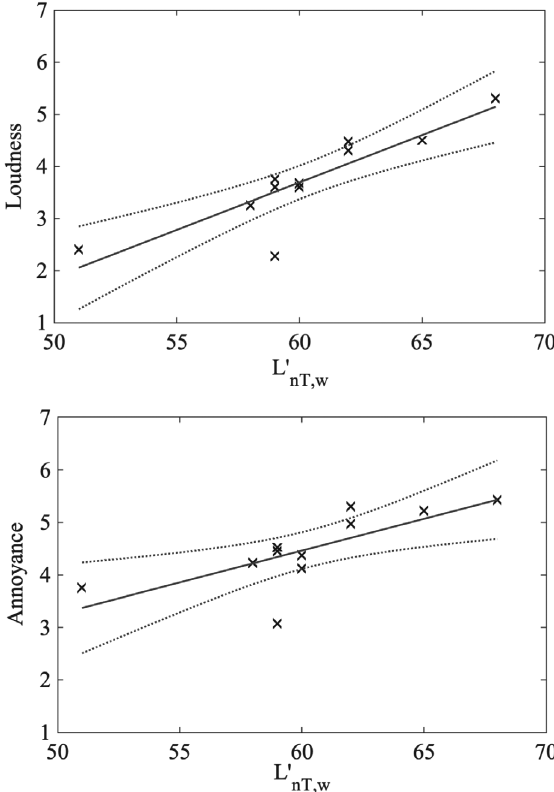
Figure 14. Relationship between impact sound insulation rating of the fl oors and the subjective loudness and annoyance of walking